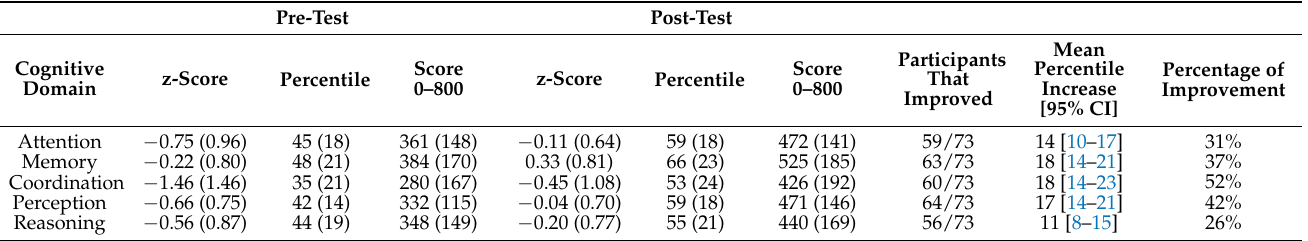
Table 1. Averaged scores and percentiles in each cognitive domain before and after the CCT. Standard deviations are provided in